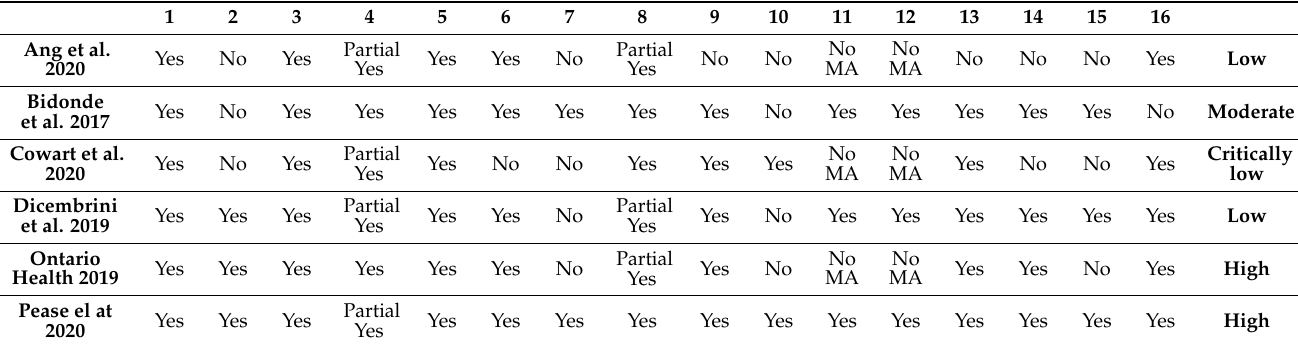
Table 3. Assessment of Multiple Systematic Reviews 2 (AMSTAR-2) ratings of systematic reviews and